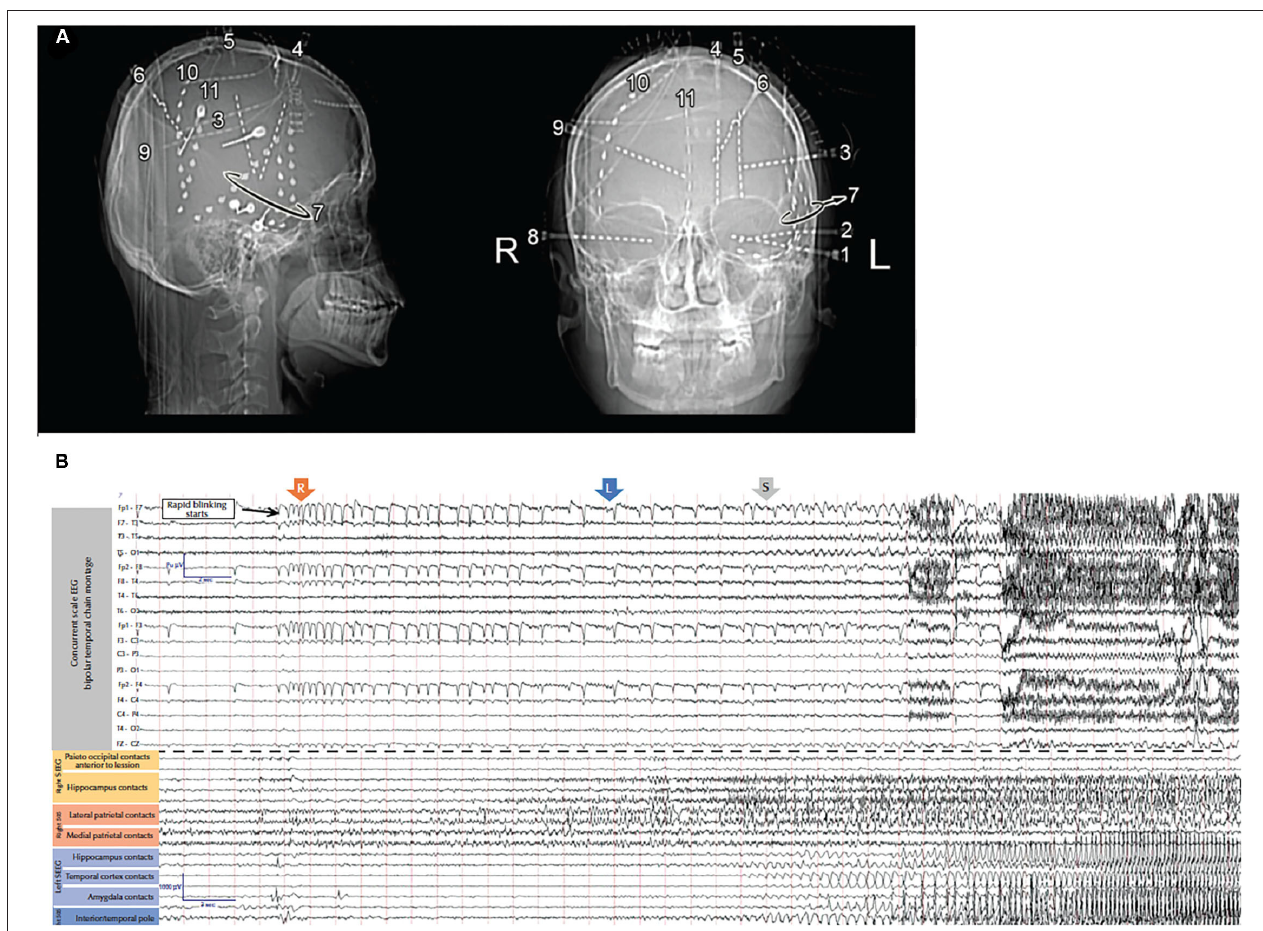
FIGURE 2 | (A) X-rays showing the locations of the intracranial electrodes. (B) Scalp (top) and intracranial (bottom) electrodes in the amygdala, hippocampus, insula, and posterior cingulate gyrus in addition to the strips sampling right parietal lesion. The EEG shows onset around the right parietal lesion with secondary propagation to the contralateral temporal lobe [adapted from (